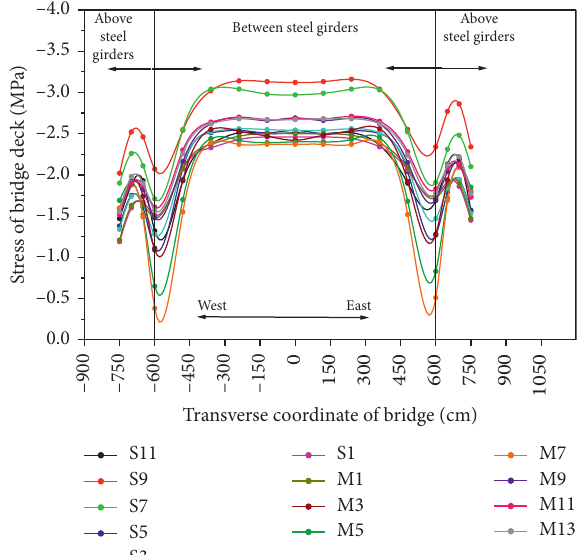
Figure 15: The stress value of the upper edge of each cross section of the bridge deck at 13